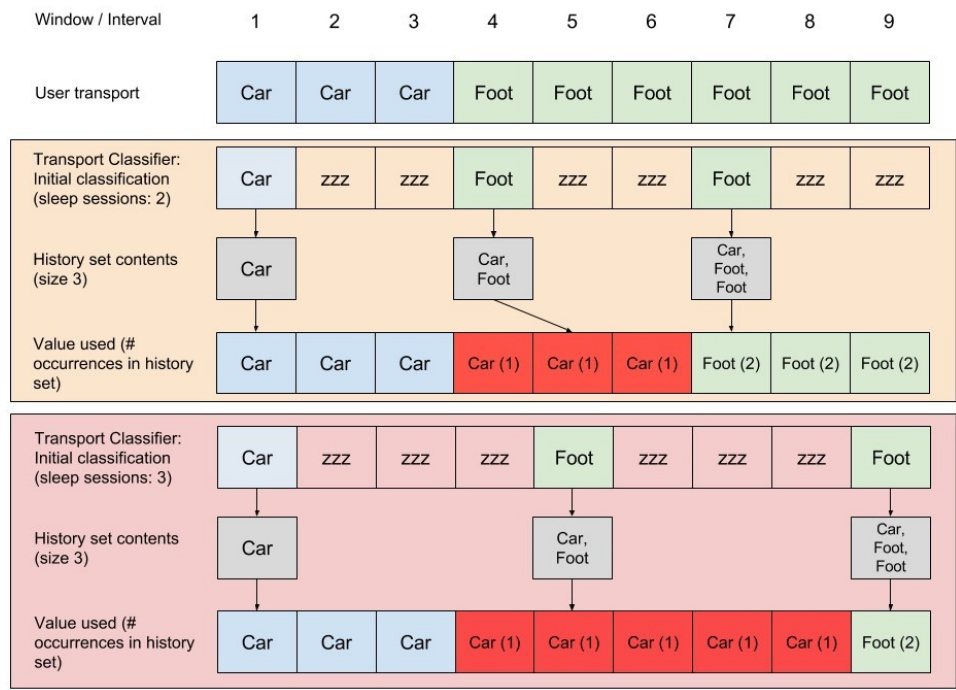
Figure 6. Effect of sensing and sleep session intervals ratio on the number of errors.